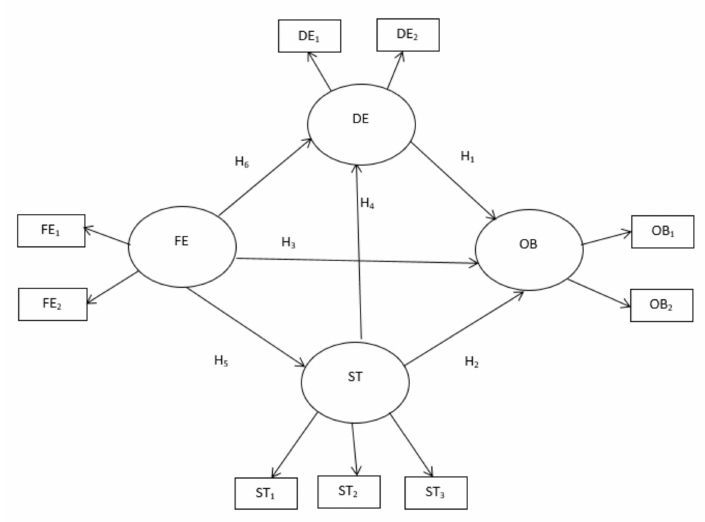
Figure 2. Structural model (Source: Self-made. DE: dysfunctional elements of tourism planning; OB: determination of objectives in tourism planning; ST: study of the territory to be planned; and FE: functional and multidisciplinary elements of